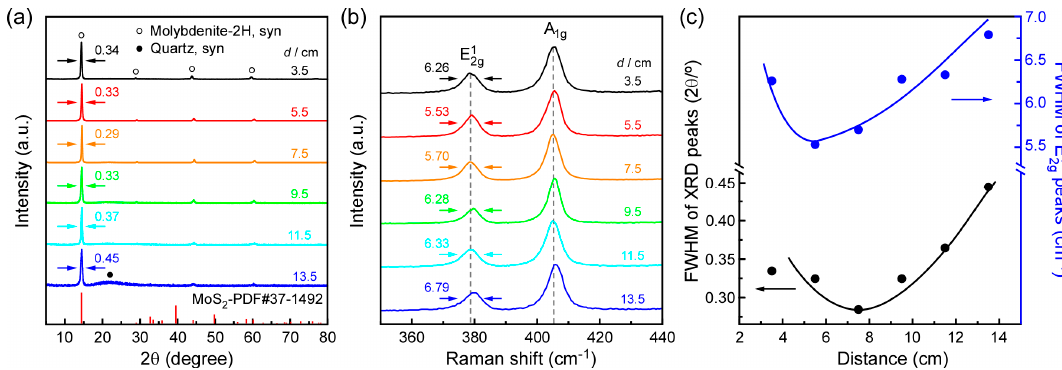
Figure 3. ( a ) XRD spectra and ( c ) the corresponding FWHM of (002) peak, ( b ) Raman spectra ( c ) the corresponding FWHM of E 12g peak.